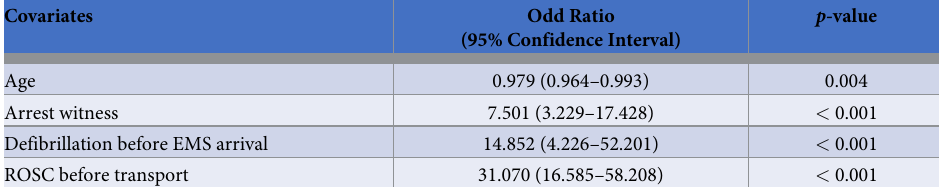
Table 3. Binary logistic regression analysis to determine the favorable neurological outcomes (CPC 1 or 2) in 1,686 patients with OHCA.